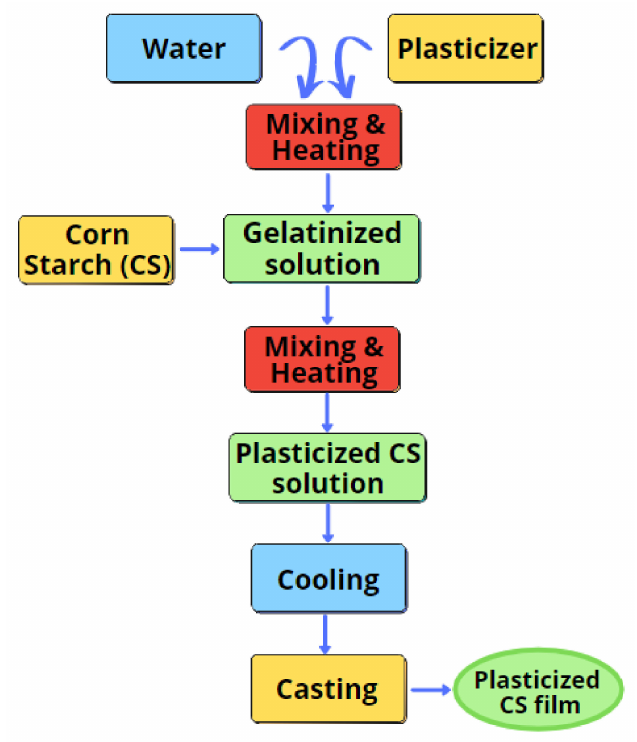
Figure 1. Flow chart of film